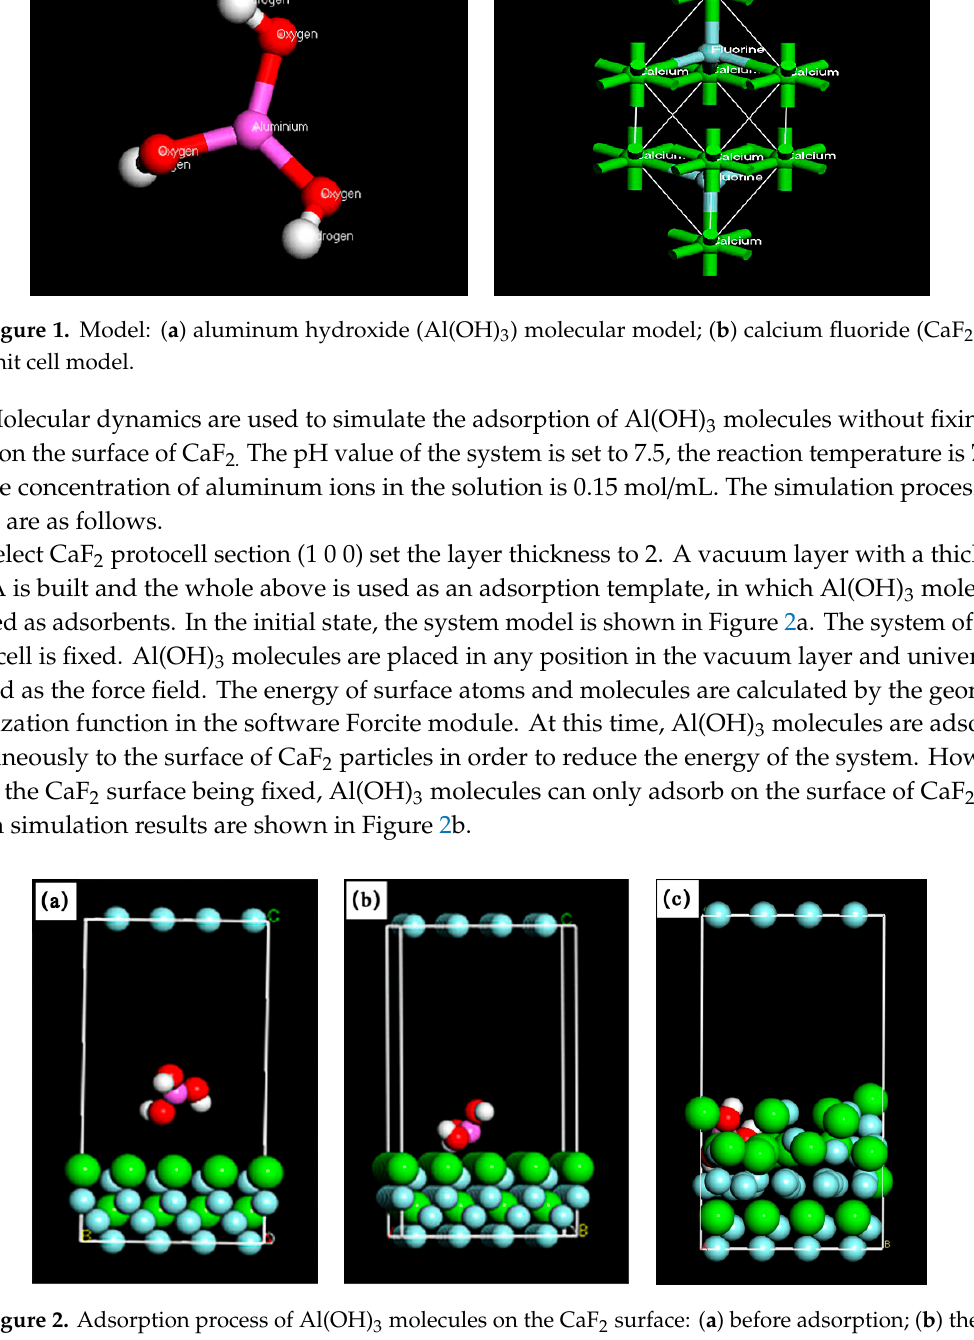
Figure 1. Model: ( a ) aluminum hydroxide (Al(OH) 3 ) molecular model; ( b ) calcium fluoride (CaF 2 ) unit cell model.